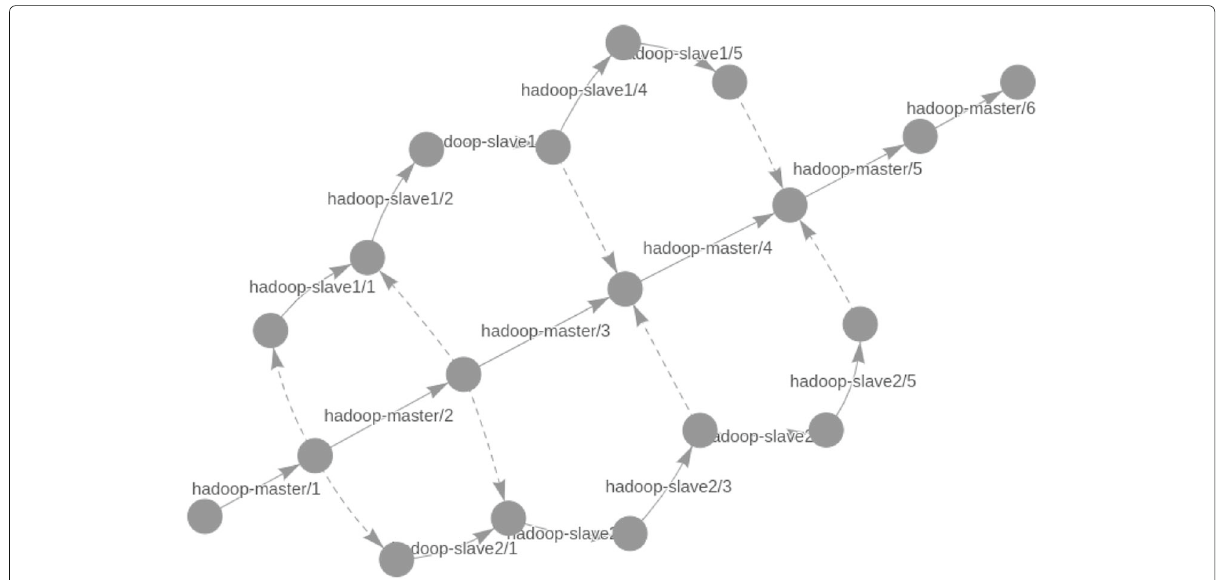
Fig. 6 Hadoop deployment graph with 1 master and 2 slave